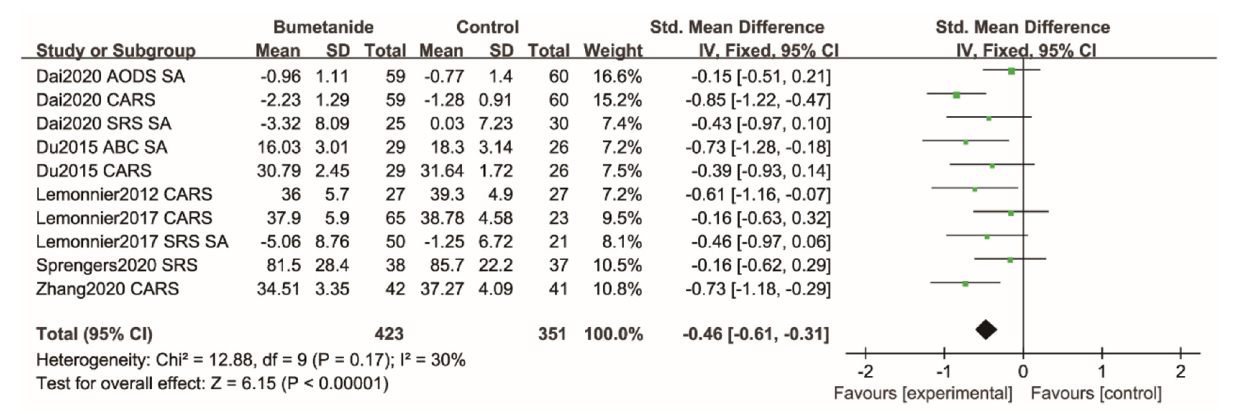
FIGURE 6 | Forest plot of the efficacy of bumetanide on SA in children with ASD. ADOS, Autism Diagnostic Observation Schedule; CARS, Childhood Autism Rating Scale; SA, Social Affect; SRS, Social Responsive Scale; ABC, Autism Behavior Checklist.